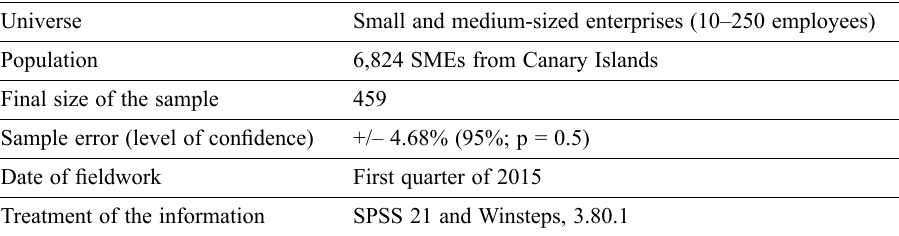
Table 2. Specifications of the empirical